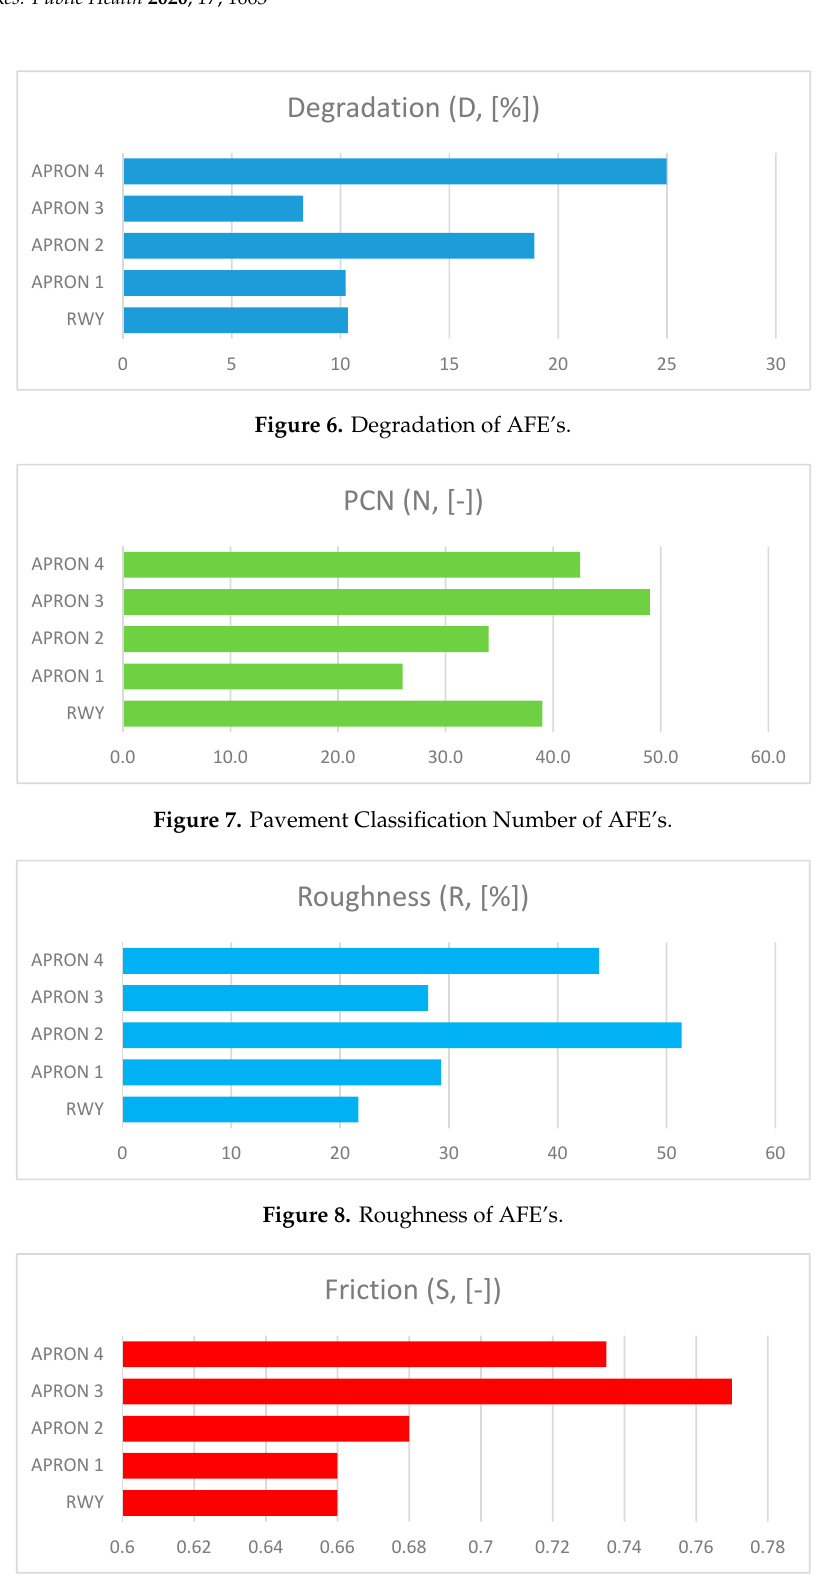
Figure 9. Friction of AFE’s.